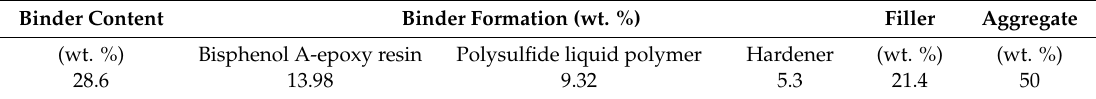
Table 6. Binder formation ratio and mixing ratio of polysulfide polymer